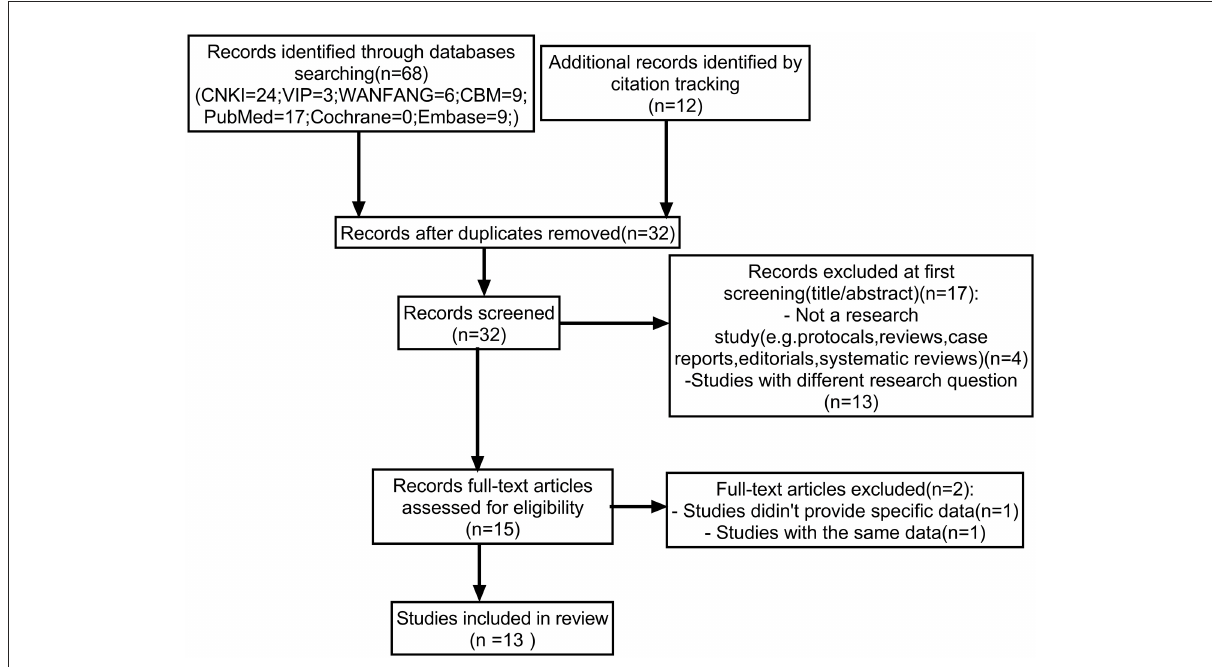
FIGURE1 Flowchart diagram of the study selection for systematic